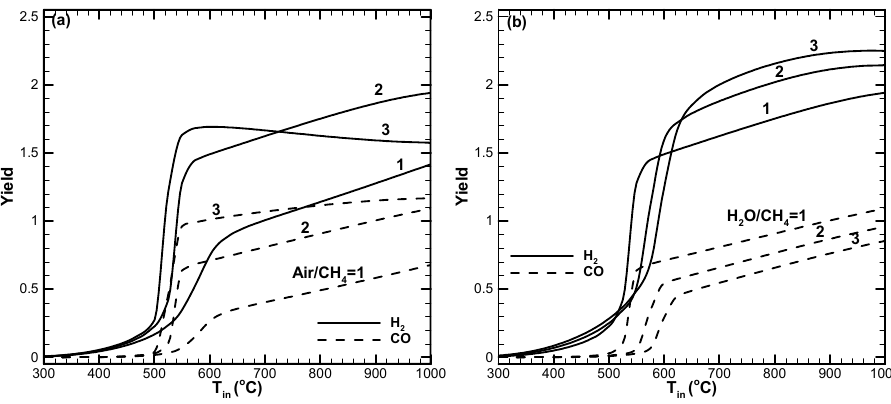
Figure 10. H 2 and CO yields for various ( a ) air and ( b ) H 2 O amounts added.